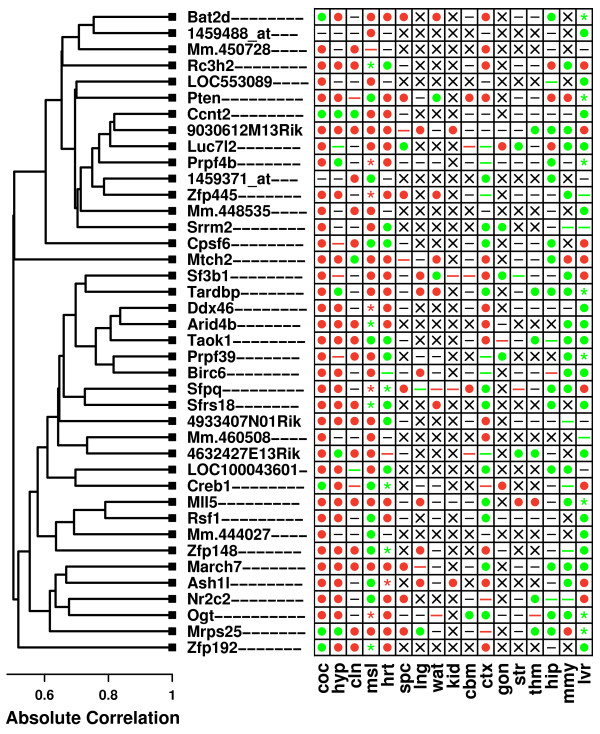
Gene expression module regulated by CR. The figure shows a 40-gene co-expression module that is regulated by CR across multiple tissue types. Symbols shown within the grid reflect results of differential expression analyses for individual genes and tissues, given a comparison-wise type I error rate of 0.05 (i.e., no p-value adjustment for multiple testing of hypotheses). These symbols have the same interpretation as those shown in Figure 2. The columns of the grid, corresponding to individual tissue types, have been ordered from those for which module genes are most strongly up regulated by CR, to those for which module genes are most strongly down regulated by CR. The dendrogram (left) reflects the co-expression patterns among the 40 genes belonging to this module, which are based upon the expression of genes across a set of 3,700 Affymetrix 430 2.0 oligonucleotide arrays (see Methods). The dendrogram was generated by average linkage hierarchical cluster analysis, with distance between genes based upon the absolute value of Pearson's correlation coefficient (i.e., distance = 1 - |r|). Other CR-regulated co-expression modules were identified in the analysis, and further detail on the most significant of these is provided in Additional File 6.